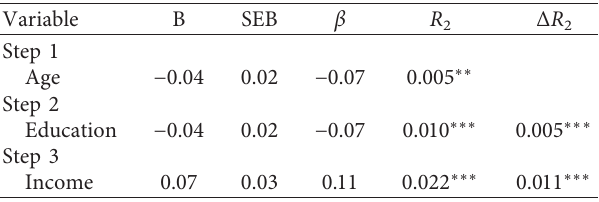
Table 4: Hierarchical regression analysis for variables predicting ritual beliefs ( N � 2400).